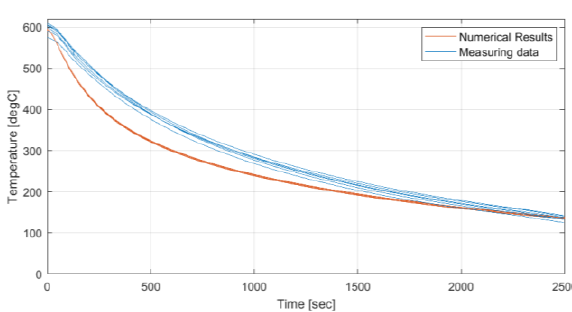
Fig. 19. Comparing the experimental and numerical results on shaft tube .